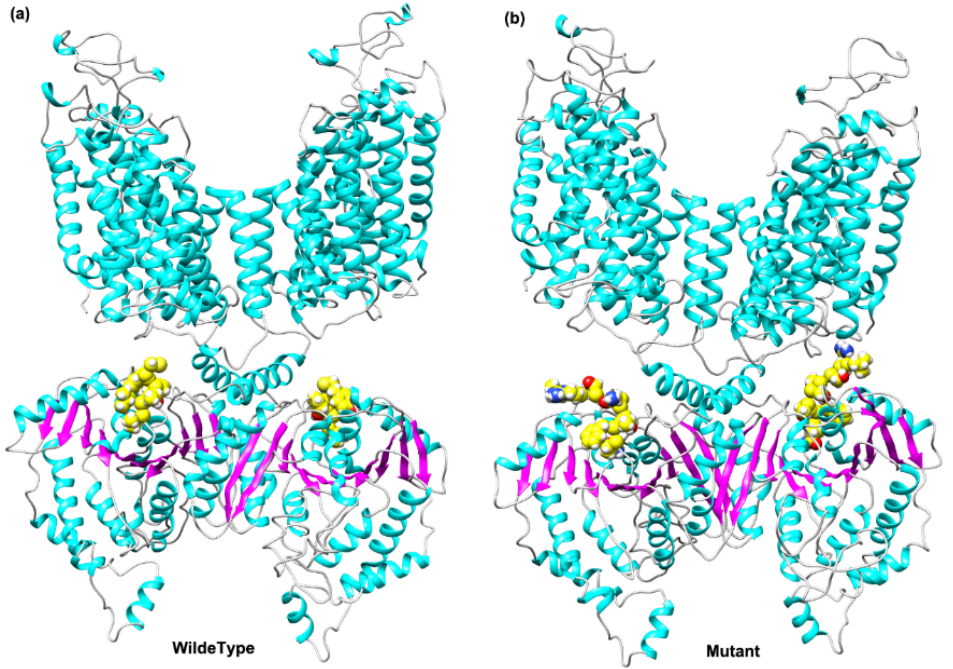
Figure 5. Structural models of the protein encoded by SLC12A3 ( a ) and the mutant ( SLC12A3 c.3070_3079delinsCAG) ( b ). Yellow spheres indicate mutated amino acid residues.